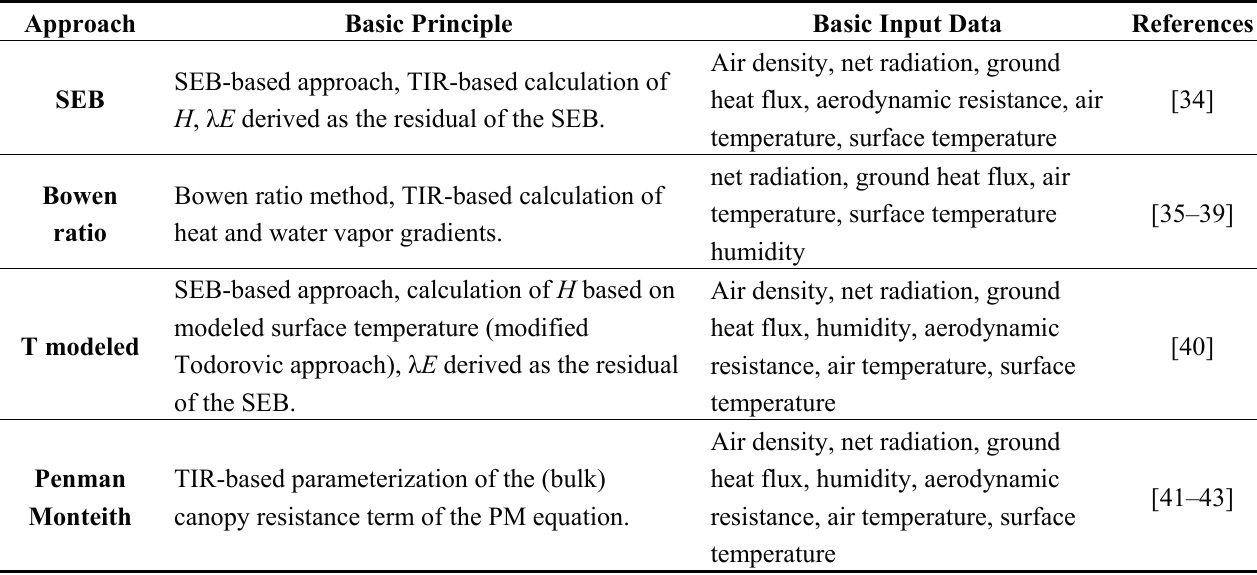
Table 1. Summary of the four modeling approaches: basic principle, input data and references. SEB, surface energy balance; TIR, thermal infrared; PM,